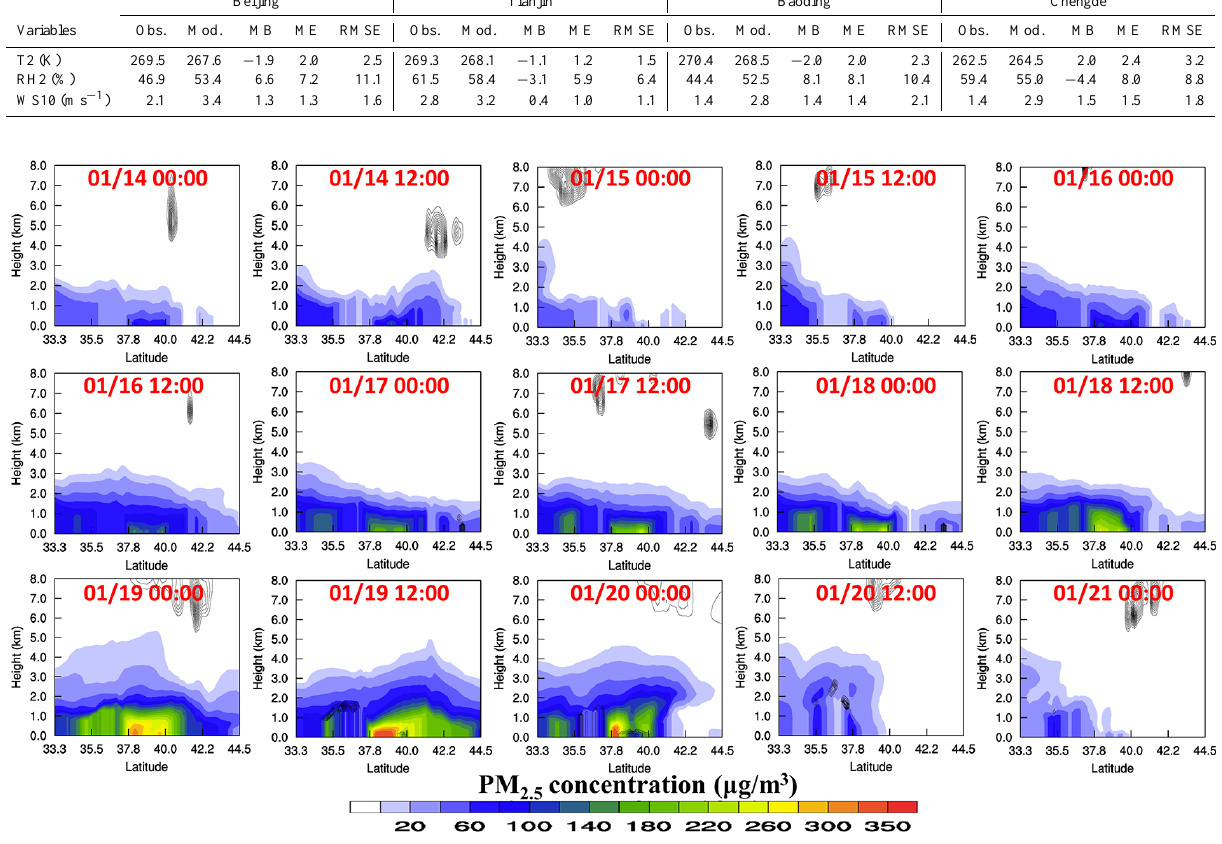
Figure 7. Cross section plots of PM 2 . 5 concentration and clouds from 14 January 00:00 to 21 January 00:00 every